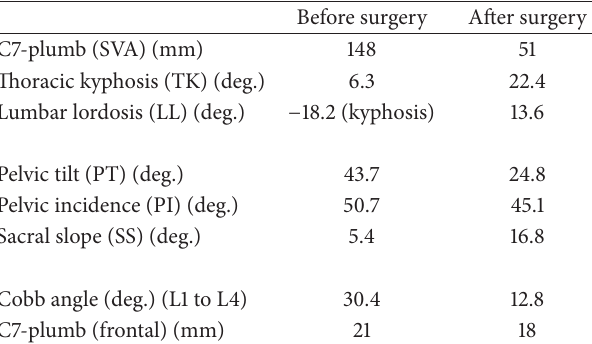
Table 2: Radiographic parameter (Case2). Before surgery After surgery 51 6.3